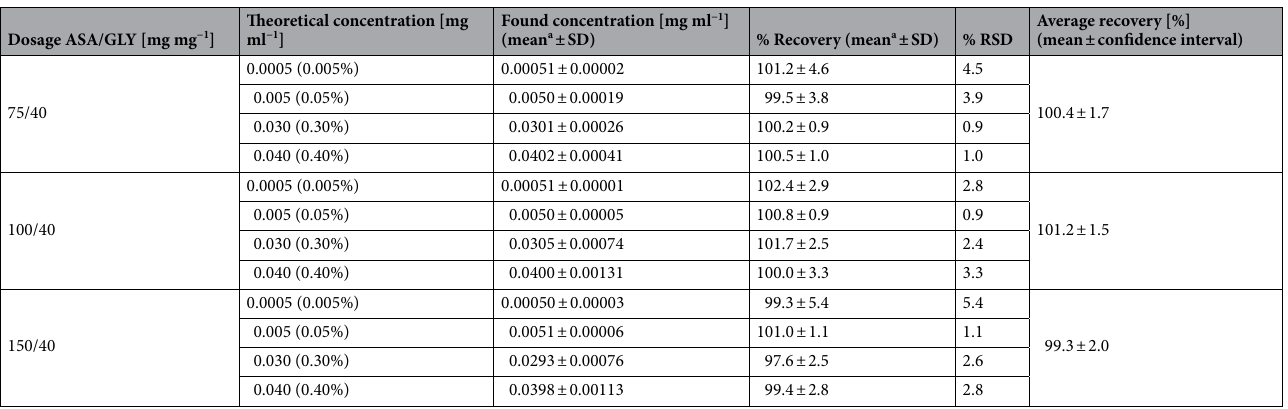
Table 3. Accuracy. a Mean value of three independent